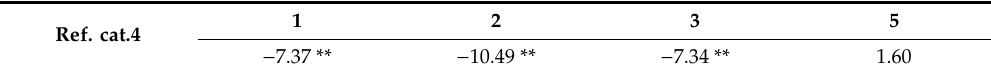
Table 6. Regression coe ffi cients for all dummy variables included in 2b